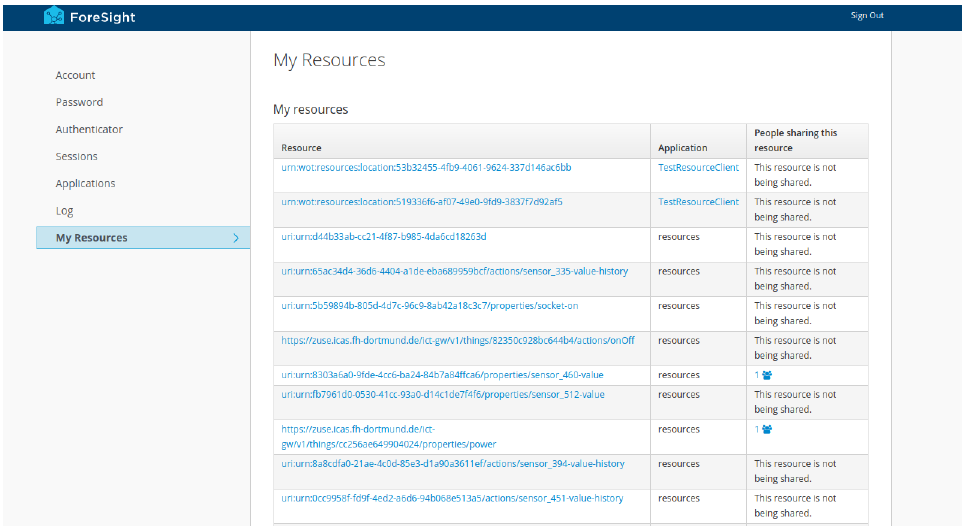
Figure 3. UMA 2.0 interface of